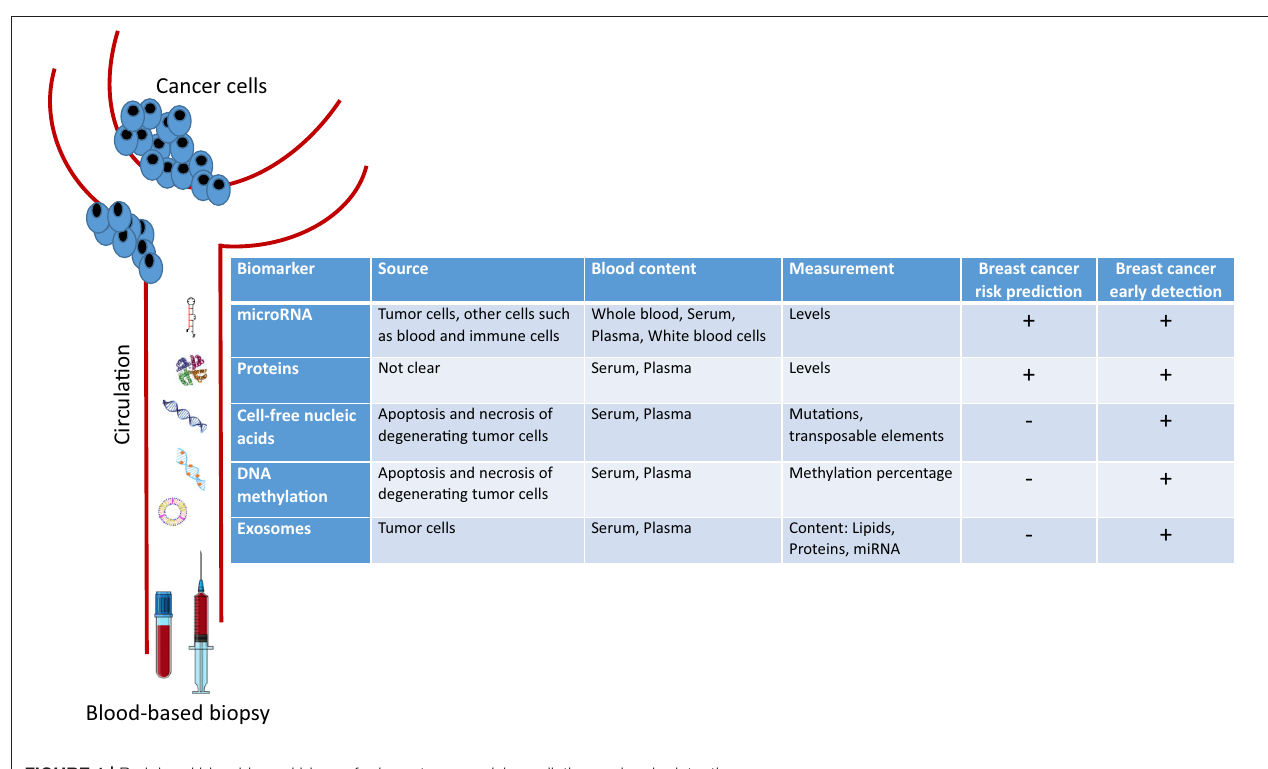
FIGURE 1 | Peripheral blood-based biopsy for breast cancer risk prediction and early